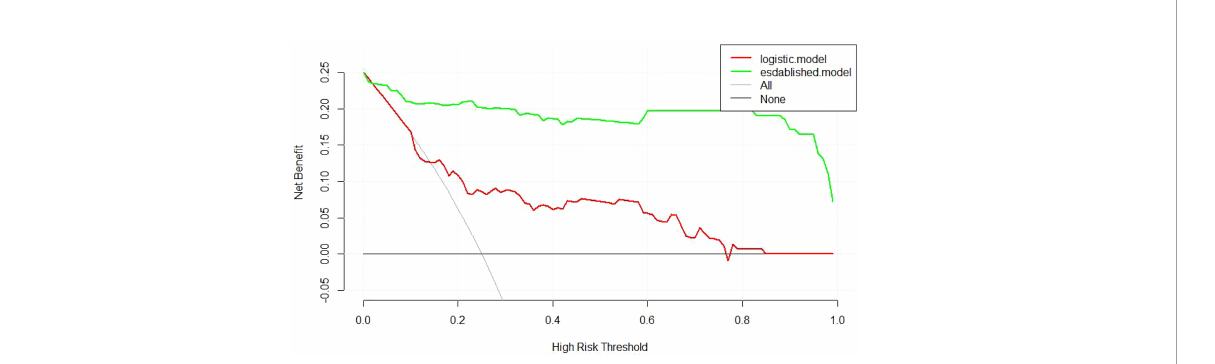
FIGURE 6 Decision curve analysis of the two models. “ None ” is the net bene fi t when it is assumed that none of the JDM patients will have the outcome (anti-MDA5 positive). “ All ” is the net bene fi t when it is assumed that all the JDM patients will have the outcome. ‘ established ’’ logistic ’ represents the net bene fi t when JDM patients are screened the predicted risk of anti-MDA5 estimated by different prediction models, respectively. Thestrategy with the highest net bene fi t at any given threshold is the preferred